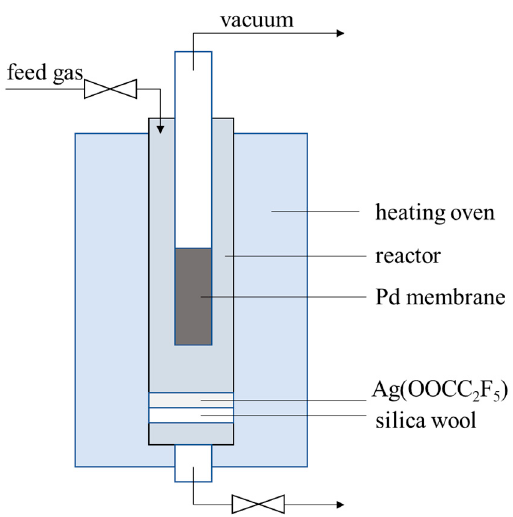
Figure 1. The illustration of the membrane cell for onsite repair treatment. Table 1. Performance data of the Pd-Ag alloy membranes investigated in this study.